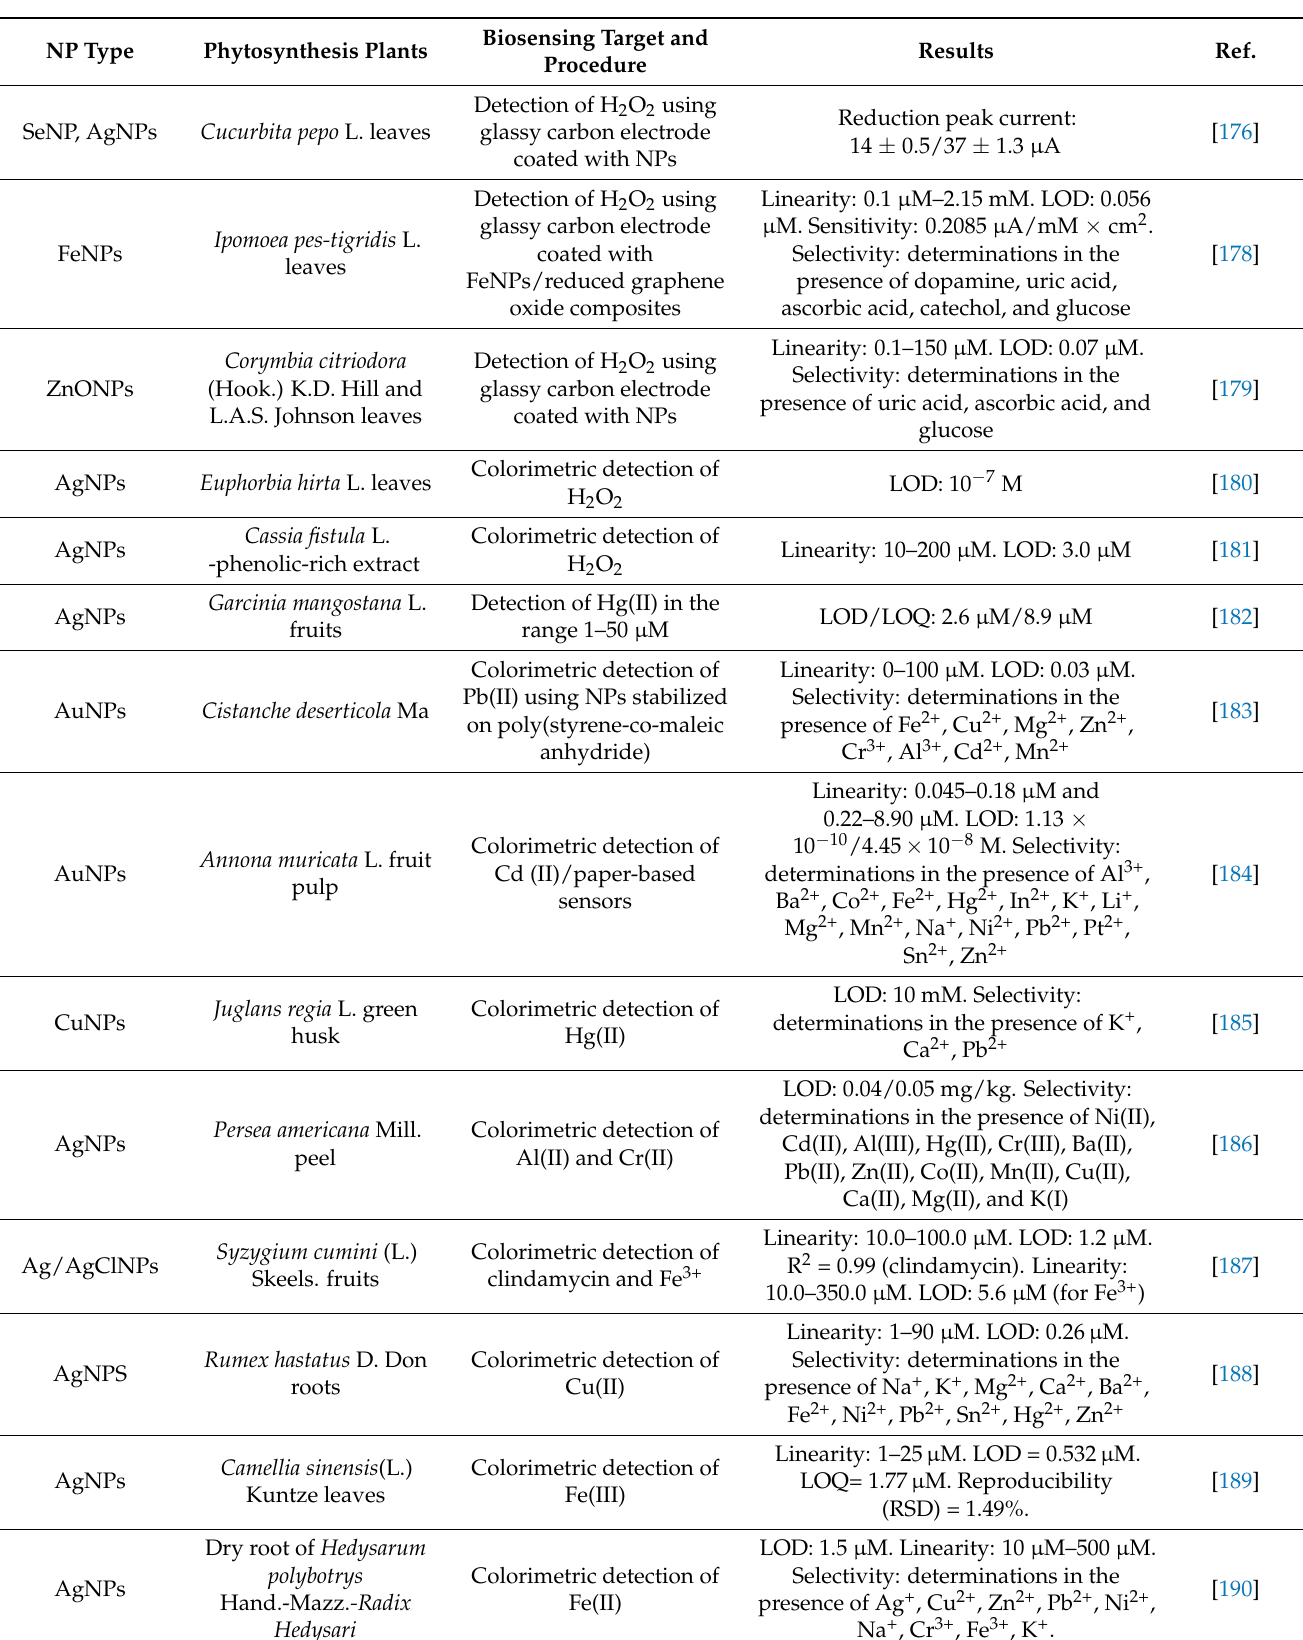
Table 2. Biosensing using phytosynthesized nanoparticles